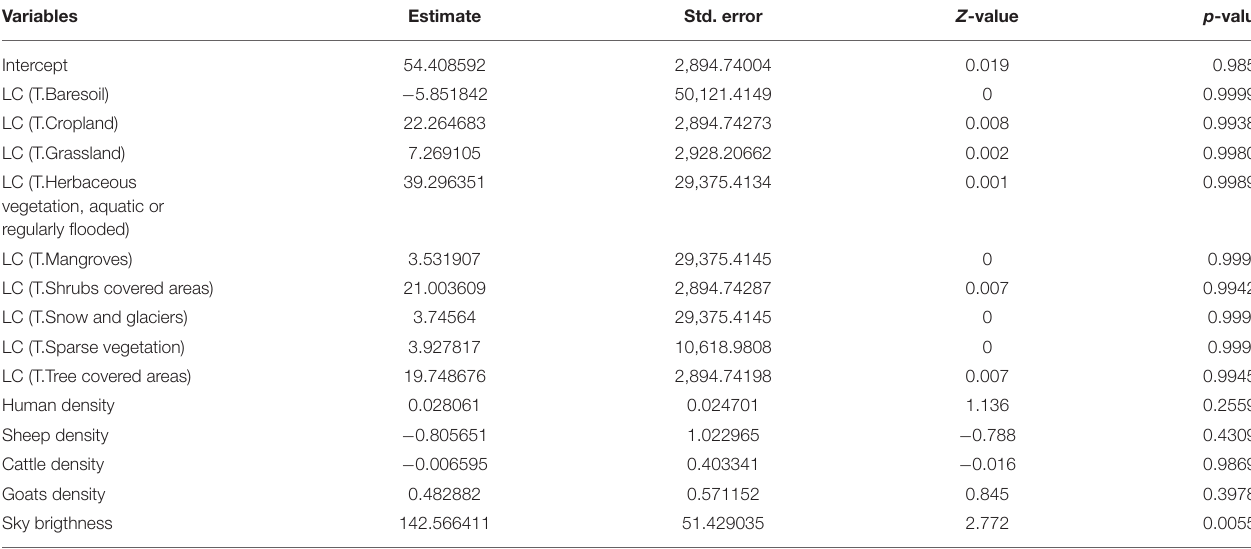
TABLE 2 | Results of GLM using the five continuous standardized variables and “land cover” as factor. Variables